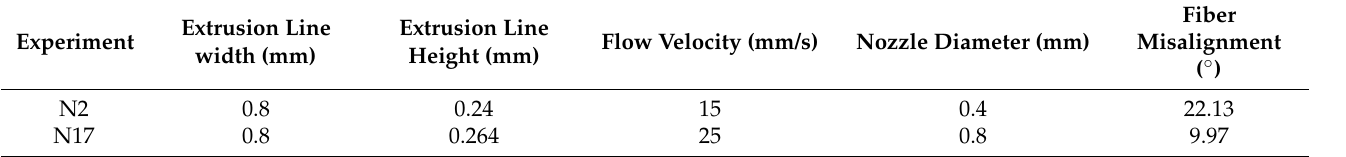
Table 4. Comparison of N2 and N17 extrusion line geometry and fiber alignment.